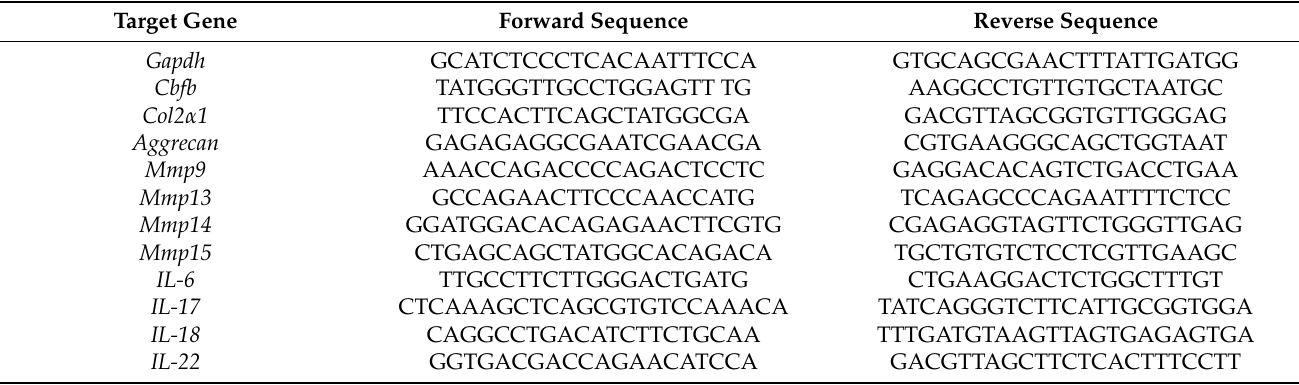
Table 3. Primer sequences for